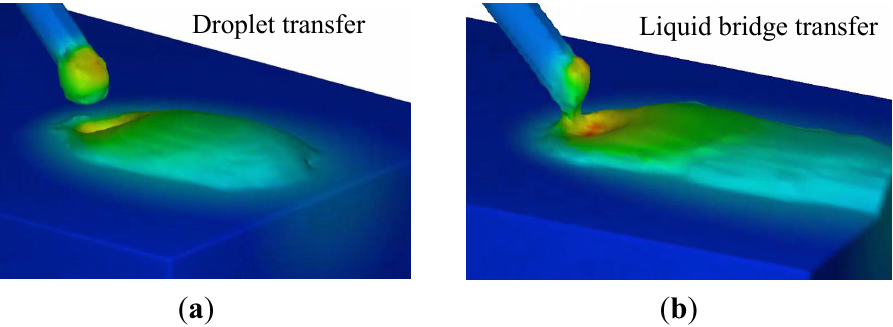
Figure 7. Verification of critical condition for the transition from liquid bridge to droplet mode: ( a ) initial distance H 0 = 0.14 cm, ( b ) initial distance H 0 = 0.12